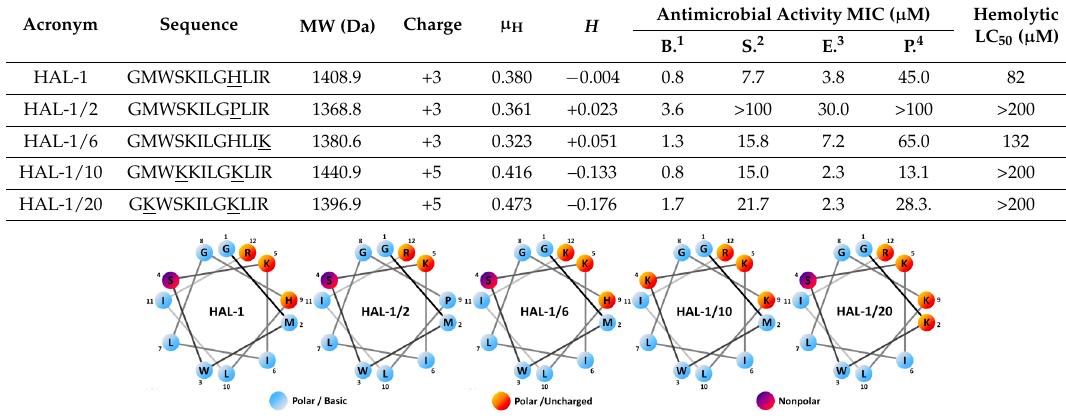
Table 1. Amino acid sequences, physico-chemical and biological properties (µ H is the hydrophobic moment, and H represents the mean hydrophobicity, calculated according to [27]), of the studied antibacterial HAL-1 peptides. Data were taken from ref. [19]. Point mutations with respect to the natural HAL-1 peptide are underlined. The Schi ff er − Edmundson wheel projection of the HAL-1 and its analogs is depicted below the